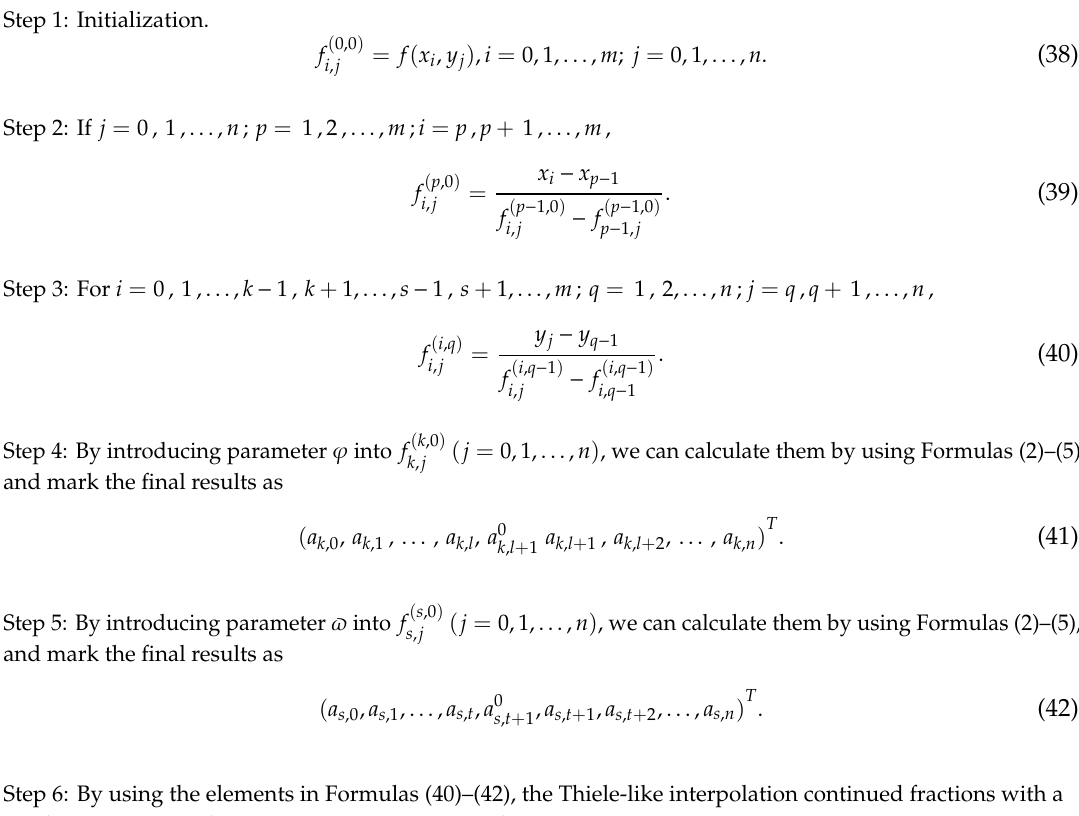
Algorithm 4 Algorithm of the Thiele-like rational interpolation continued fractions with two parameters on the di ff erent